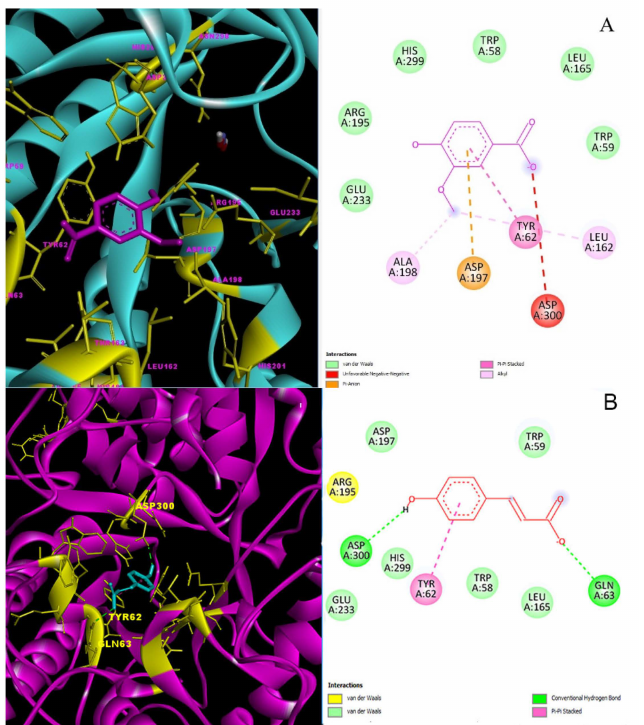
Figure 6. The 2D and 3D interaction profiles and best interaction poses of major phenolic com- pounds placed into the α -amylase enzyme (2QV4) by docking study: ( A ) Vanillic acid– α -amylase; ( B ) p -Coumaric acid– α